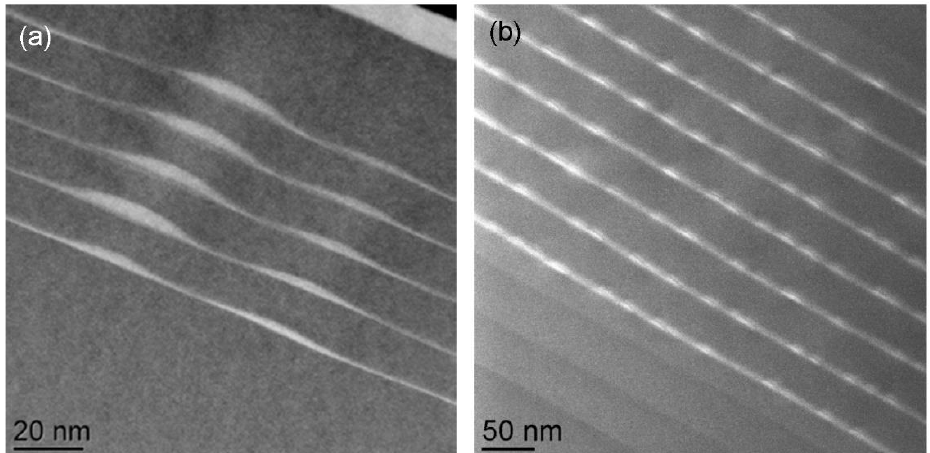
Figure 6. Cross-sectional ADF images of multi-layer stacks of ( a ) five repeats of 0.76 nm InP QDs with 12 nm AlInP barriers (reproduced from [35]) and ( b ) eight repeats of 0.8 nm (2.7 ML) InAs QDs with 5 nm InGaAs wells and 33 nm GaAs barriers from (reproduced from [36]).